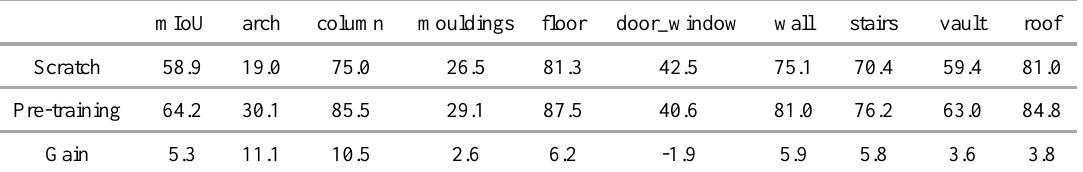
Table 3. Comparing the per-category prediction results of two pipelines utilising KPConv as the backbone and three scenes from the ArCH Dataset as training